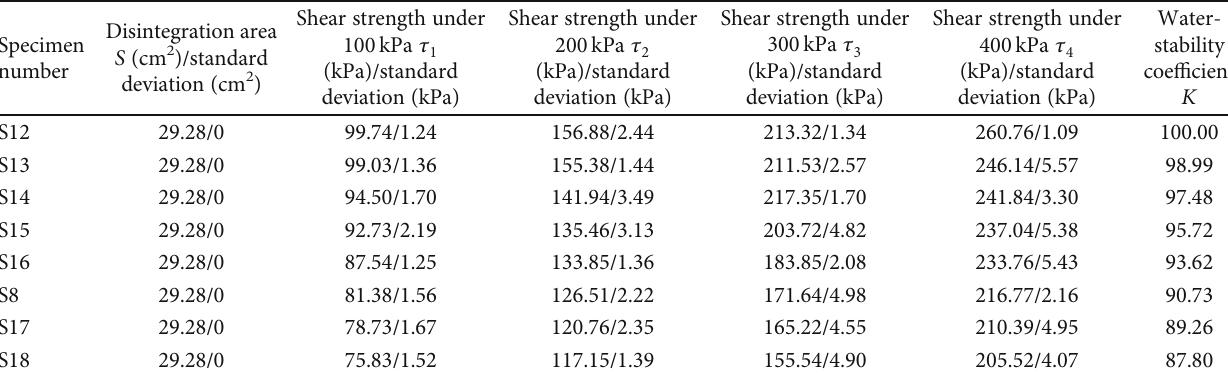
Table 5: The results of the test with di ff erent immersion times.